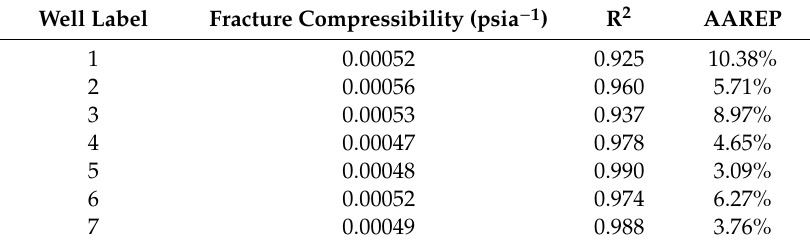
Figure 6. Comparison of predicted and field data of TMS wells. Table 3. Calculated R 2 and AAREP values for TMS wells. Table 3. Calculated R 2 and AAREP values for TMS wells.